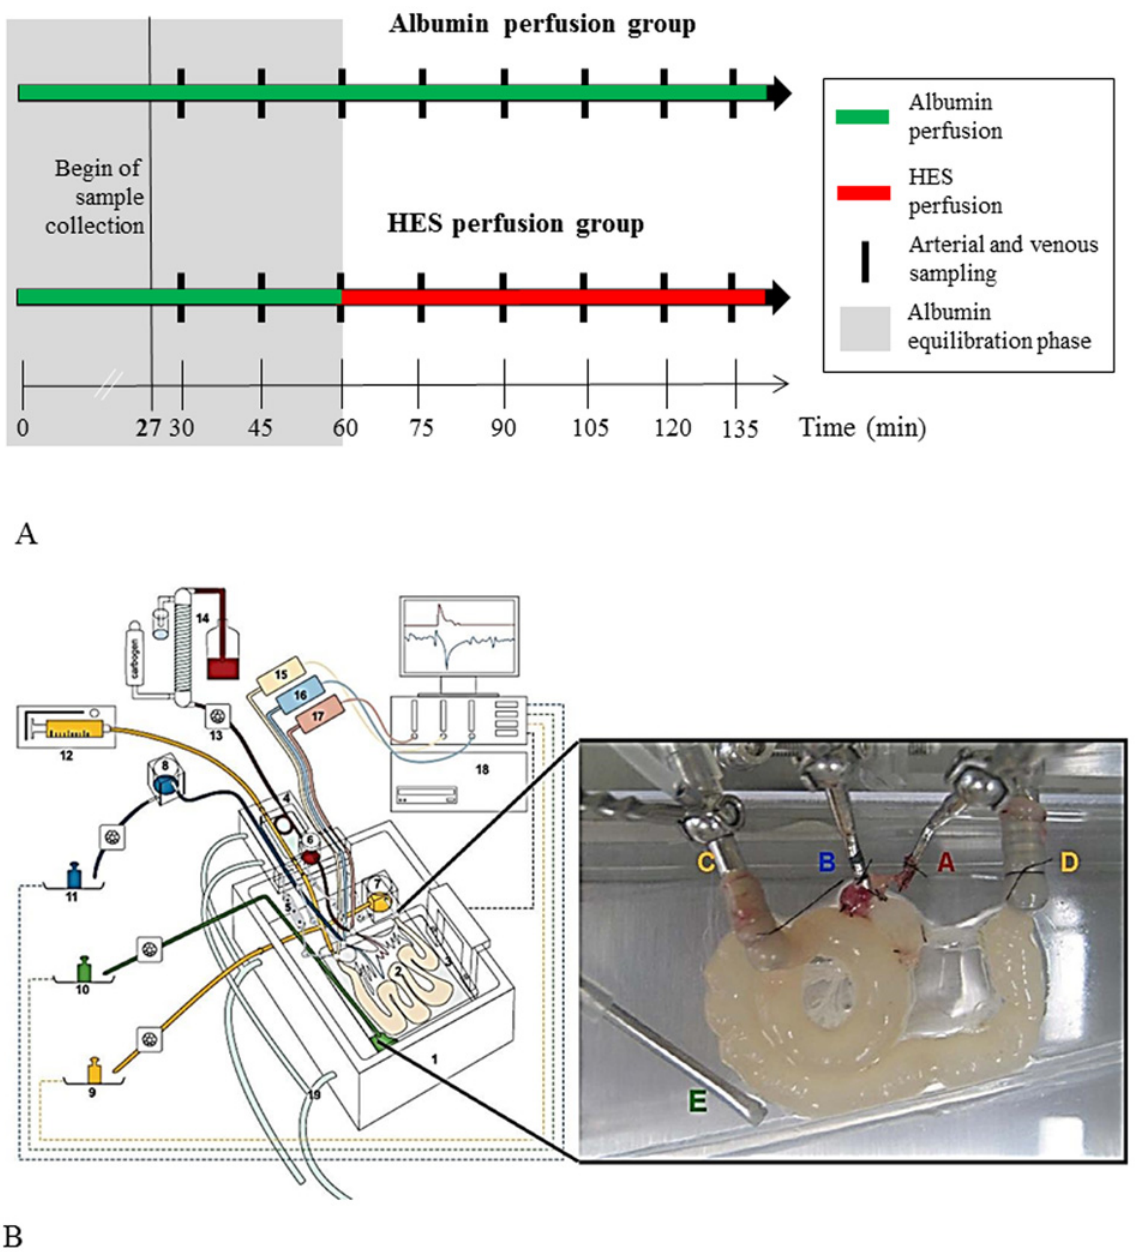
Fig 1. Experimental setting and basic components of the perfusion model. A) Experimental setting and time frame B) isolated perfused mouse small intestine apparatus. Using a custom made, heated chamber (1) an isolated small intestine (2) is perfused (vascular system: red, blue; luminal system: yellow; lymphatic system: green) while placed on a built-in microbalance (3). A moveable cannulating block (4) carries the tubings, heat exchanger cannula holders (5), and bubble trap (6). Height-adjustable reservoirs (7, 8) allow clamping both afterloads to zero. For online analysis of fluid homeostasis all emanating liquids are quantified by use of three balances (9 to 11). Constant flow perfusion is applied by a syringe pump (12) and a roller pump (13). The vascular perfusate is pH equilibrated, oxygenated and prewarmed with a tempered hollow fiber dialyzer flushed with carbogen gas (14). Pressure transducers (15 – 17) allow online detection of the luminal (yellow), venous (blue) and arterial (red) pressures. All data are recorded on a personal computer (18). To secure constant temperature, the chamber and cannulating block are water-jacketed and warmed by a water bath (19). The inset shows a representative photograph of a perfused small intestine. A, arterial cannula; B, venous cannula; C, oral intestinal lumen cannula; D, aboral intestinal lumen cannula; E, lymphatic suction needle; modified from [14]. A representative video presentation of the perfused small intestine is available as online supporting information (S1